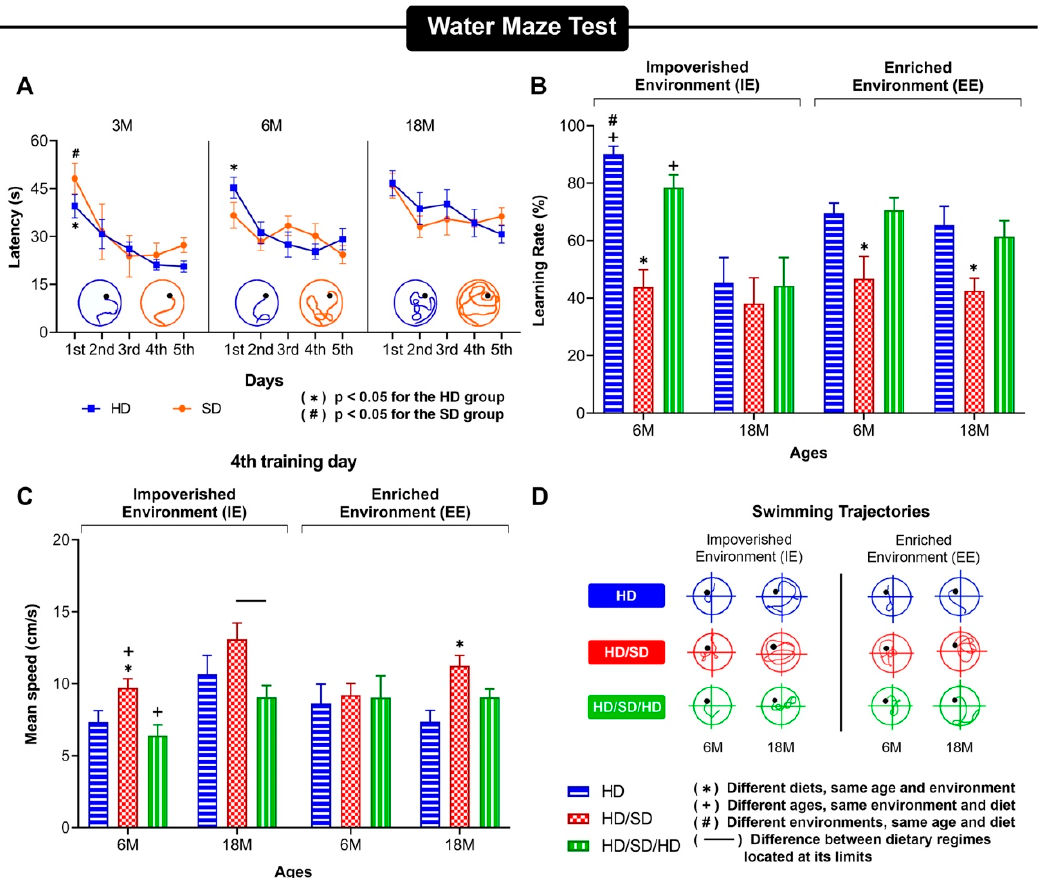
Figure 2. Influences of contrasting environments (impoverished and enriched), differential age and masticatory activity on Morris Water Maze spatial learning and memory performances in albino Swiss mice. ( A ) 3-, 6- and 18-month-old mice with correspondent mean values of escape latencies on five consecutive testing days. Blue- and orange-colored curves show progressive reduction in escape latency for hard diet (HD) and soft diet (SD) groups. Swimming tracking analysis below the curves shows that aged mice under SD exhibited longer trajectories than mice with HD at 6- and 18-month-old [30]. ( B ) Graphical representation of the influence of contrasting environments and masticatory activity rehabilitation in sequences of hard, soft, and hard diets (HD/SD/HD) on learning rate expressed as percentage 4th testing day values. Note that reduction of masticatory activity with sequences of hard and soft diet (HD/SD) reduced mouse learning rates at all ages independently of experienced environments, and this was not related to swimming speed (cm/s) ( C ). ( D ) Swimming trajectories for each group was selected based on the average distance closer to mean values of each group [31]. Results are expressed as mean ± standard error. M, month.